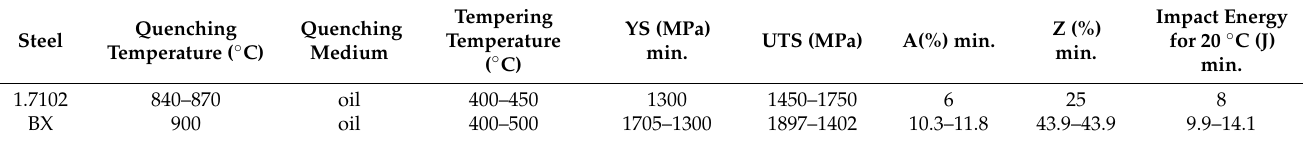
Table 6. Properties of 1.7102 steel according to ISO 8458-1 compared with steel